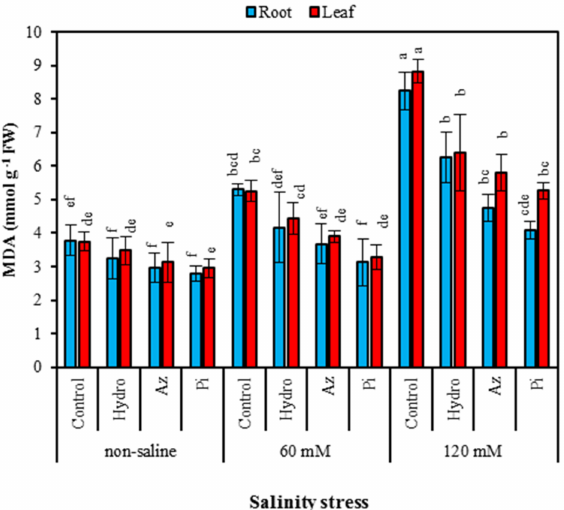
Figure 4. Effect of seed priming on malonyl dialdehyde (MDA) content of milk thistle root and leaves under different levels of salinity. The same letter within each column indicates no significant difference among treatments ( p ≤ 0.05) using New Duncan’s test. Values mean of four replicates ± SD. Hydro: hydro-priming, Az: Azotobacter chroococcum and Pi: Piriformospora indica